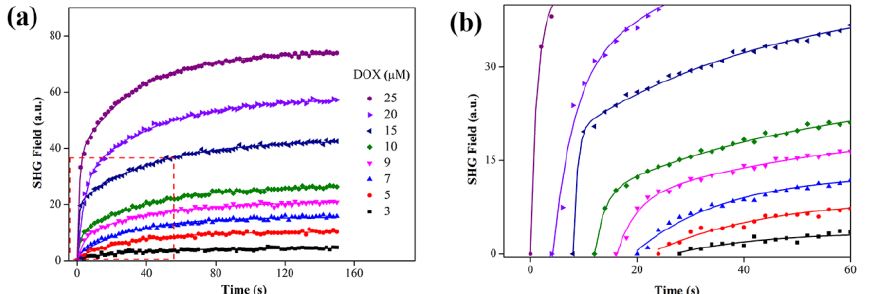
Figure 4. ( a ) Time-dependent SHG field obtained after the addition of DOX at various concentrations in 250 μ M DOPG vesicle solutions. ( b ) Magnification of the rectangle area marked by dotted lines in frame a (some curves were shifted in x direction to make the plot clear). Reproduced with permission [57]. Copyright 2019 American Chemical Society.